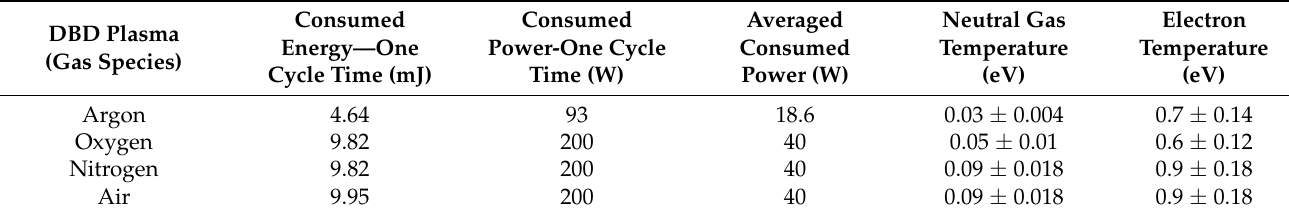
Table 1. Neutral gas and electronic temperatures are measured via OES in various gas species of DBD plasmas, including the consumed energy and power for one cycle time and the averaged consumed power during the discharge. DBD Plasma